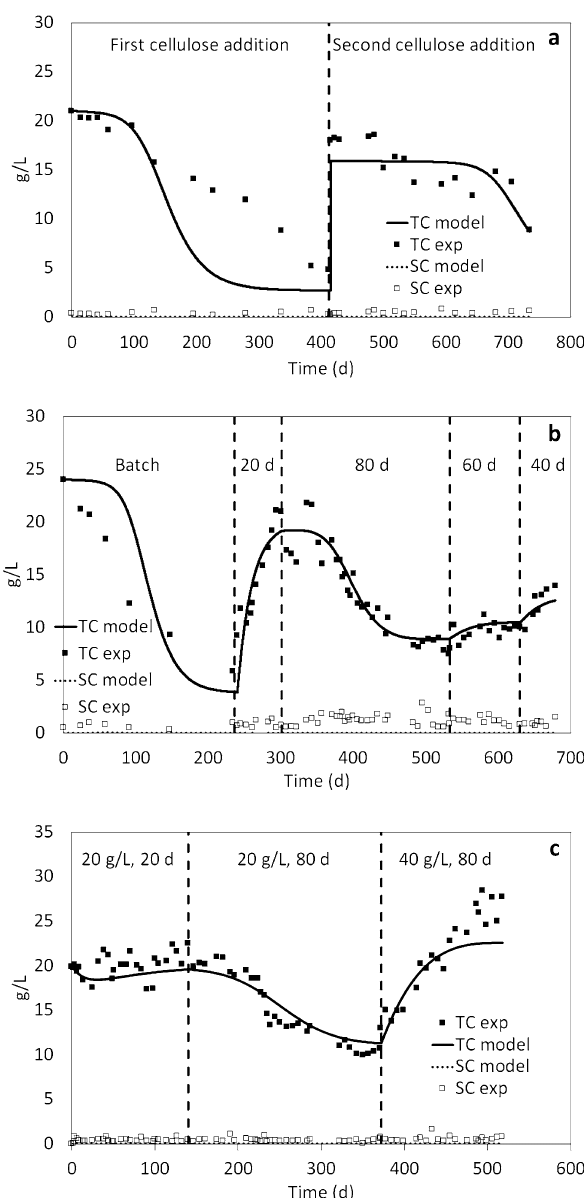
Fig. 6 Comparison of TC removal (circles) and TC removal rates (tri- angles) in the semi-continuous